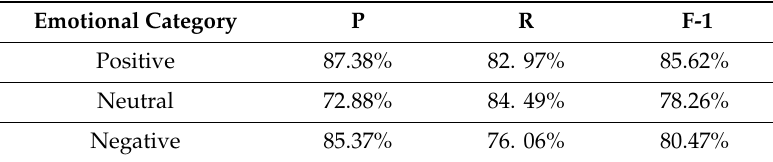
Table 3. Classification accuracy of public emotion classification.